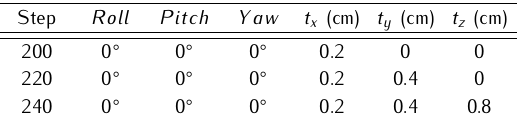
Table 4. Translational motion given to the Phantom during scanning of projections at 200°, 220°, and 240°.